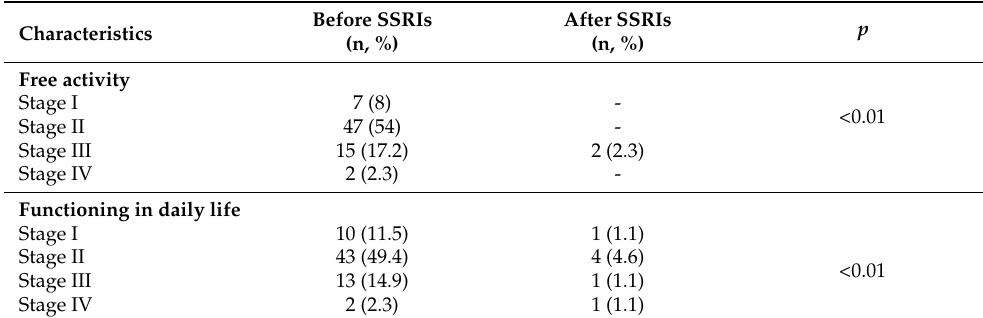
Table A4. Characteristics of physical functioning (bad) according to FEV1 before and after the use of